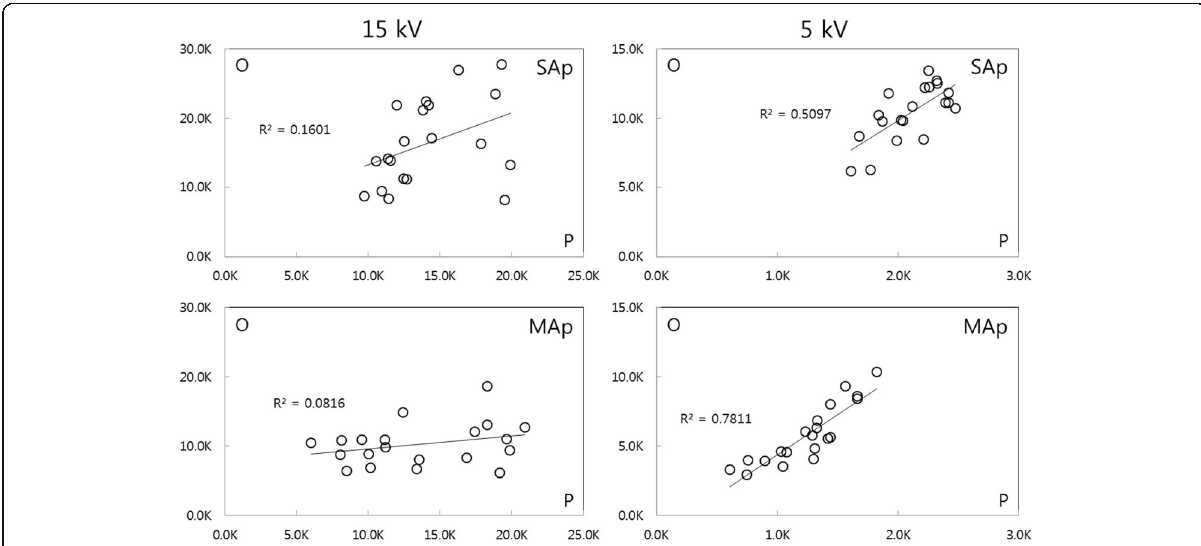
Fig. 4 Correlation of the O and P intensities for the reference materials obtained at 15 kV and 5 kV using the Mini-SEM. Data points obtained at 5 kV are closer to the linear line than those at 15 kV. The increased R 2 (coefficient of determination) at 5 kV suggests improvement of data